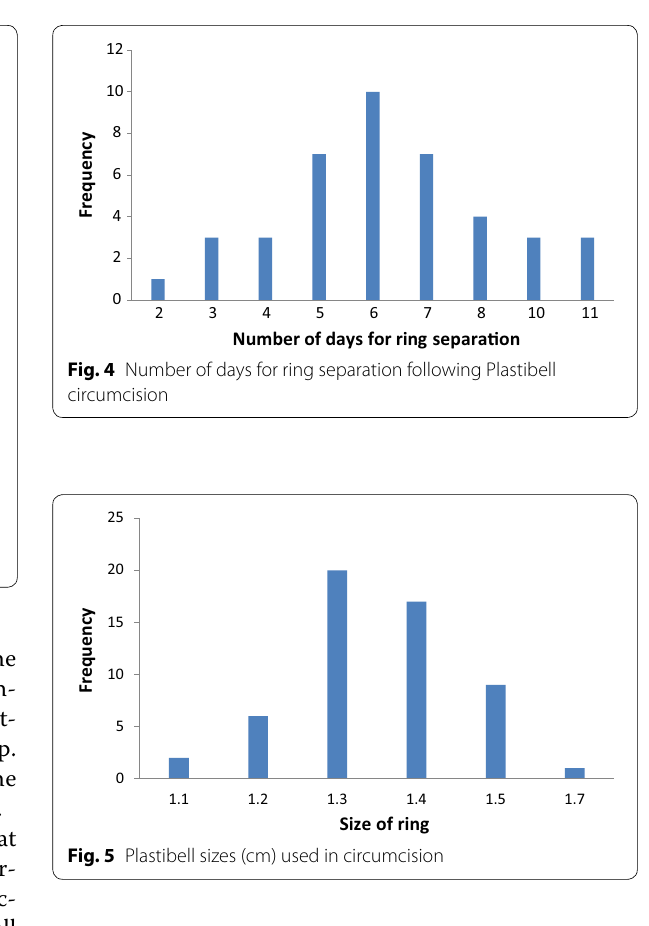
Table 3 Comparison